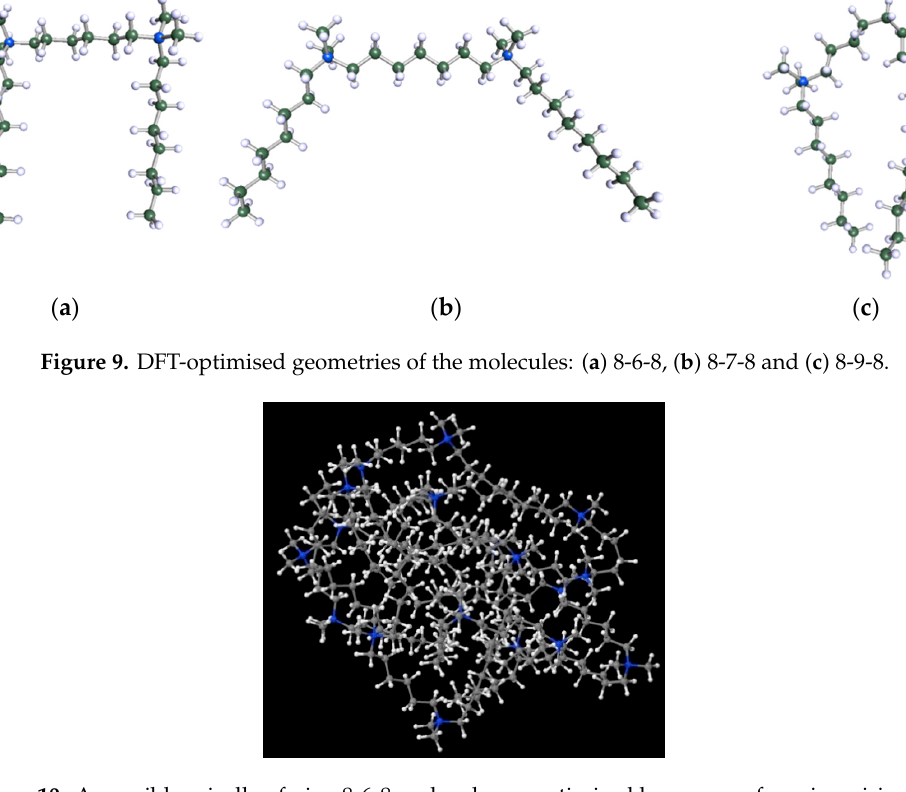
Table 1. Micelle parameters obtained from simulations based on Conductor-like Screening Model (COSMO).